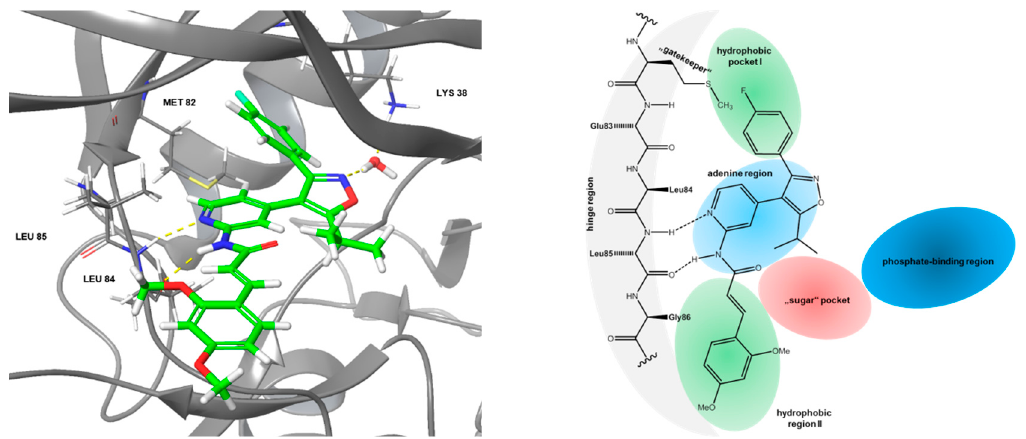
Figure 3. Left: Predicted binding mode of lead compound 8 within the ATP binding pocket of protein kinase CK1 δ (grey cartoon, pdb 3UZP [41]); hydrogen bond interactions, yellow dashed lines. Right: Schematic ligand-interaction-diagram of isoxazole 8 according to Traxler model.